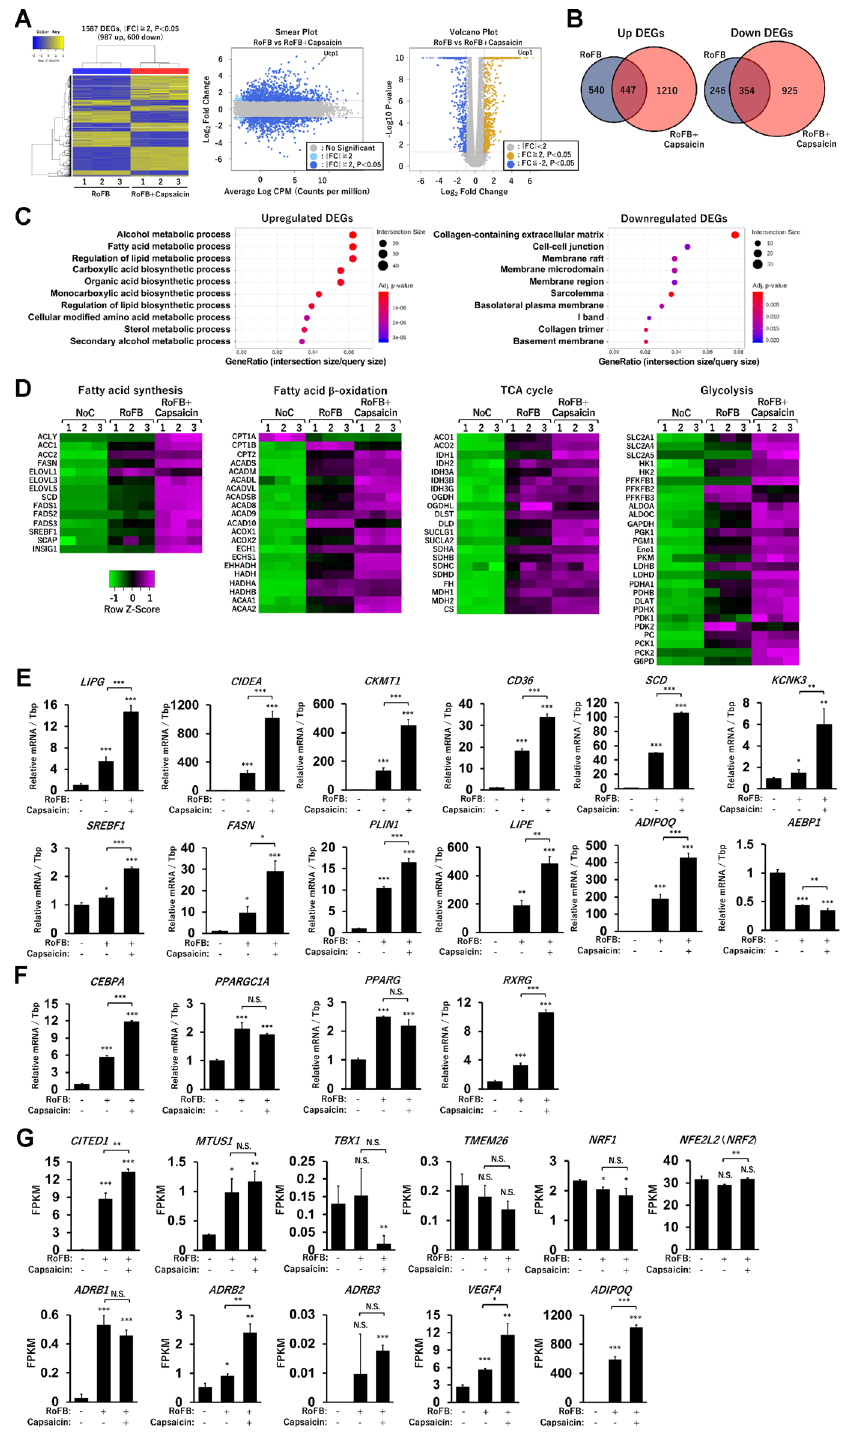
Figure 4. Genome-wide transcriptional analysis in Capsaicin-treated ciBAs. ( A ) Heat map and hierarchical clustering analysis represent 1587 differentially expressed genes (DEGs) (|fold change (FC)|≥ 2, P < 0.05) between ciBAs (RoFB) and Capsaicin-treated ciBAs (RoFB + Capsaicin). Smear and Volcano plots indicate logarithmic FC, P-value, and CPM (counts per million) between ciBAs and Capsaicin-treated ciBAs. ( B ) Venn diagrams represent overlap of up- and down-regulated DEGs between ciBAs and Capsaicin-treated ciBAs. ( C ) Gene ontology (GO) enrichment analysis was performed in the up- and down-regulated DEGs. Top 10 GO terms are represented. ( D ) Transcriptional profiles are shown as heat maps in functional groups such as fatty acid synthesis, β-oxidation, TCA cycle, and glycolysis pathway. The color scale shows z-scored fragments per kilobase of transcript per million mapped sequence reads (FPKM) representing mRNA levels of each gene in green (lower expression) and magenta (higher expression). ( E,F ) The expression of lipid metabolic genes ( E ) and transcription factors ( F ) was quantified by qRT-PCR analysis. ( G ) The FPKM values of brown/beige adipocyte-enriched genes such as CITED1 , MTUS1 , TBX1 , TMEM26 , NRF1 , NFE2L2 ( NRF2 ), ADBR1 , ADBR2 , ADBR3 , VEGFA , and ADIPOQ were obtained from the RNA-Seq results. Data represent mean ± SD (n = 3). Student’s t -test: * P < 0.05, ** P < 0.01, *** P < 0.001, N.S.; not